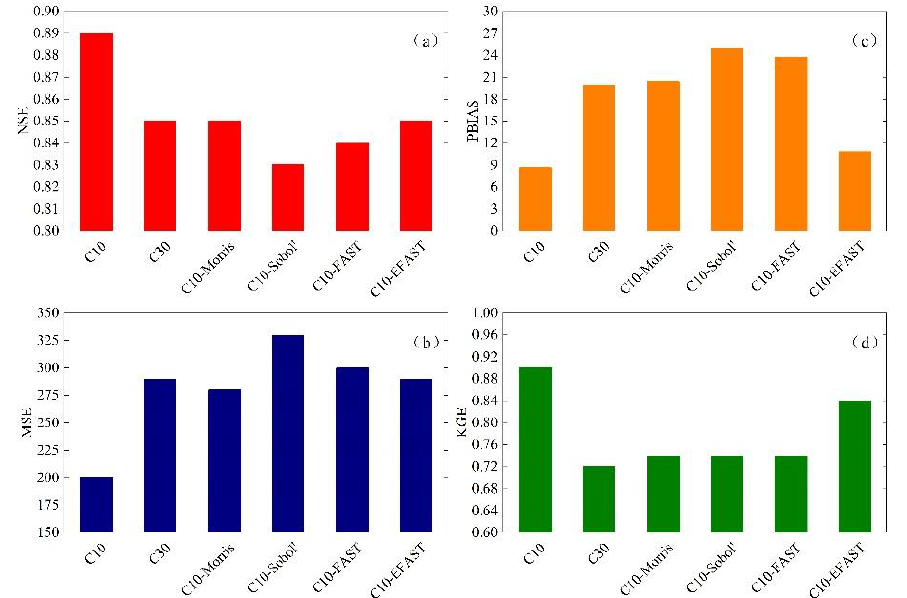
Figure 14. Comparison of four statistical values under different parameters optimization scenarios: ( a ) NSE; ( b ) mean square error (MSE); ( c ) percentage bias (PBIAS); ( d ) Kling–Gupta efficiency coefficient (KGE).